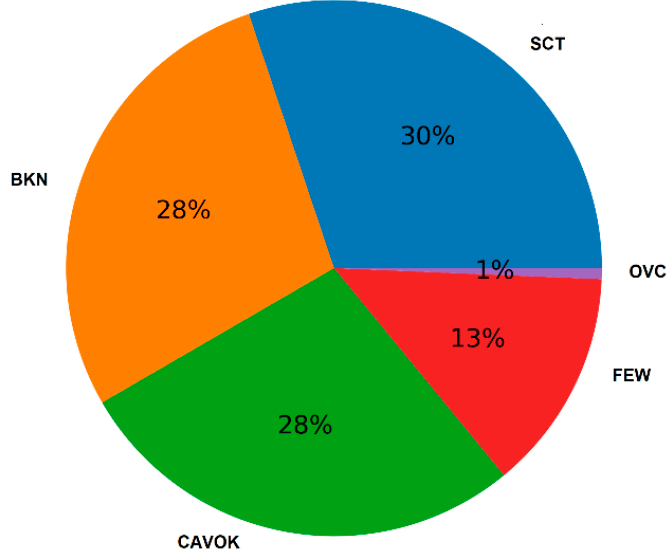
Figure 3. Cloud coverage at Santarém-PA for the 2019–2020 period.